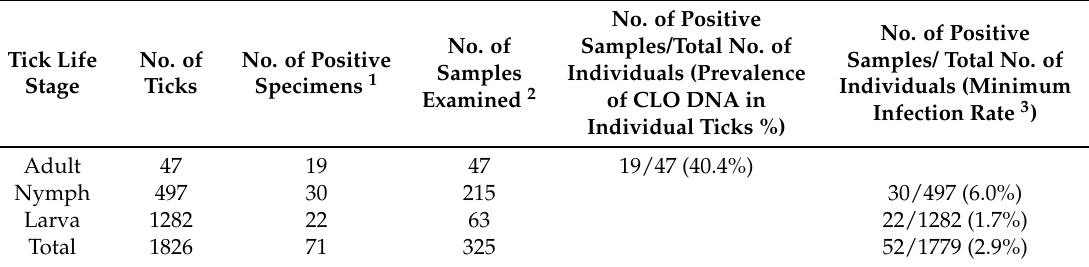
Table 1. Prevalence of Chlamydiales DNA in Ixodes tick life